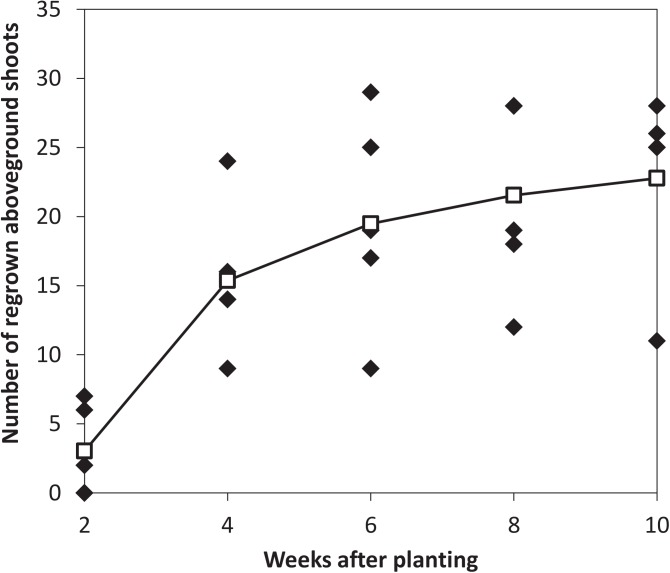
Number of regrown shoots.Observed number of regrown aboveground shoots and best fitted line for each of the five soil bags containing 20 rhizomes. Observations were made every two weeks. The predictions are based on inverse regression.